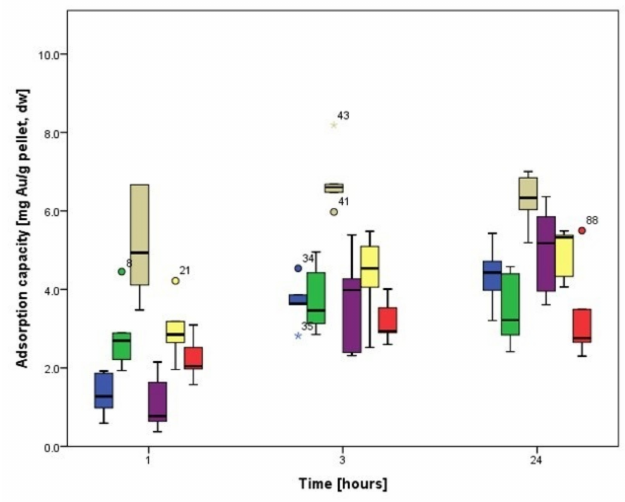
Figure 5. Au adsorbed on Aspergillus tabacinus pellets at different pH values and contact times. pH: (cid:4) : 2; (cid:4) : 3; (cid:4) : 4; (cid:4) : 5; (cid:4) : 6; (cid:4) :